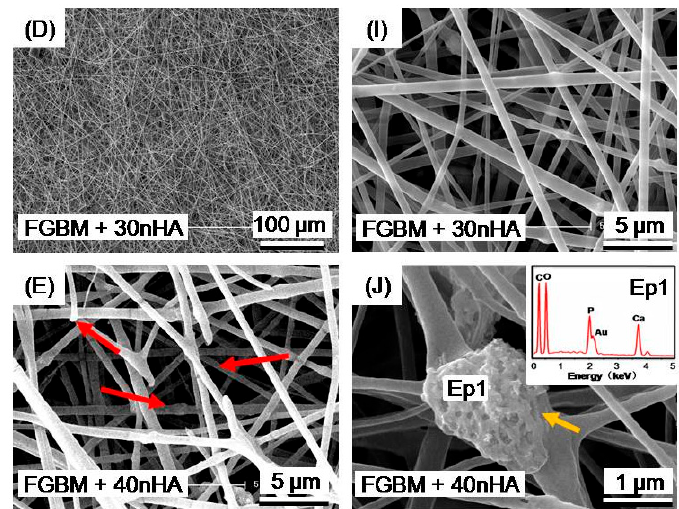
Figure 3. SEM micrographs of electrospun nanofiber membranes with different contents of nHA: ( A , F ) FGBM control (0% nHA); ( B , G ) FGBM + 10 nHA (10% nHA); ( C , H ) FGBM + 20 nHA (20% nHA); ( D , I ) FGBM + 30 nHA (30% nHA); and ( E , J ) FGBM + 40 nHA (40% nHA). All images presented a porous and interconnected structure composed of nano-sized fibers with a diameter distribution between 0.8 and 1.2 μ m except FGBM + 40 nHA ( E , J ). The 40% nHA incorporation would lead to the frequent eletrospun fiber fracture and obvious nHA crystal agglomeration. The red arrows in ( E ) show the discontinuity of nanofibers. The yellow arrows in ( J ) show the presence of nHA particles agglomeration on the fiber surface. Ep1 is an EDX (energy dispersive X-ray) spectrum of selected point on crystal indicating presence of phosphorous (P) and calcium (Ca). SEM, scanning electron microscope. FGBM, functionally graded bilayer membrane.